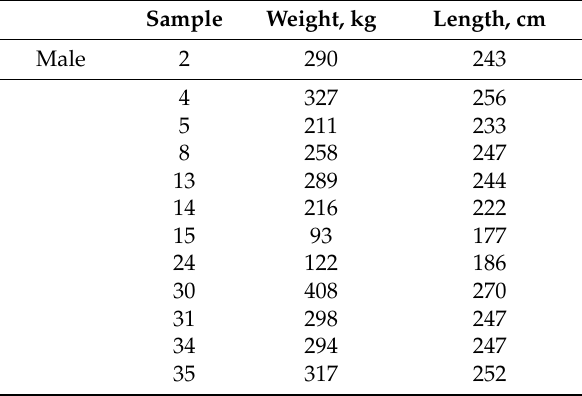
Table 1. Biometric measurements of farmed Atlantic bluefin tuna